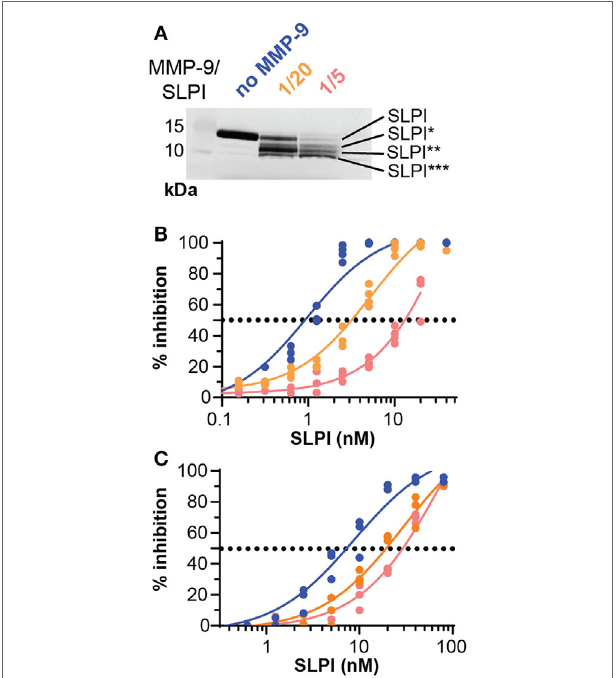
FigUre 3 | Proteolysis of secretory leukocyte peptidase inhibitor (SLPI) by matrix metalloprotease-9 (MMP-9) reduces antiproteolytic activity against neutrophil elastase (NE). (a) Digestion of SLPI at 1/20 and 1/5 molar ratio of MMP-9/SLPI. Representative image of several batches (Figure S2 in Supplementary Material). (B) Percentage inhibition of NE gelatinolytic activity by SLPI (blue), MMP-9/SLPI 1/20 (orange), and MMP-9/SLPI 1/5 (red). Data fitted with a four-parameter dose-response fit, n = 3–4. (c) Percentage inhibition of NE activity to degrade a small fluorogenic NE substrate by SLPI (blue line), MMP-9/SLPI 1/20 (orange line), and MMP-9/SLPI 1/5 (red line). Data fitted with a four-parameter dose-response fit, n = 3.